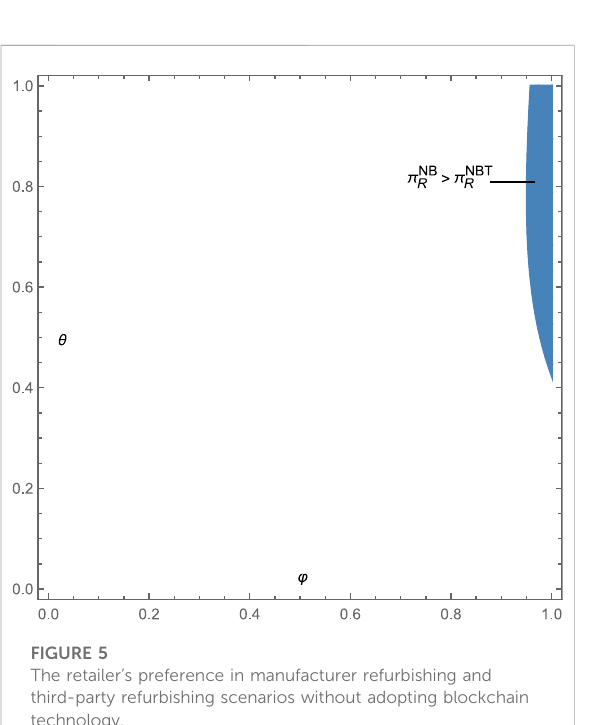
FIGURE 5 The retailer ’ s preference in manufacturer refurbishing and third-party refurbishing scenarios without adopting blockchain